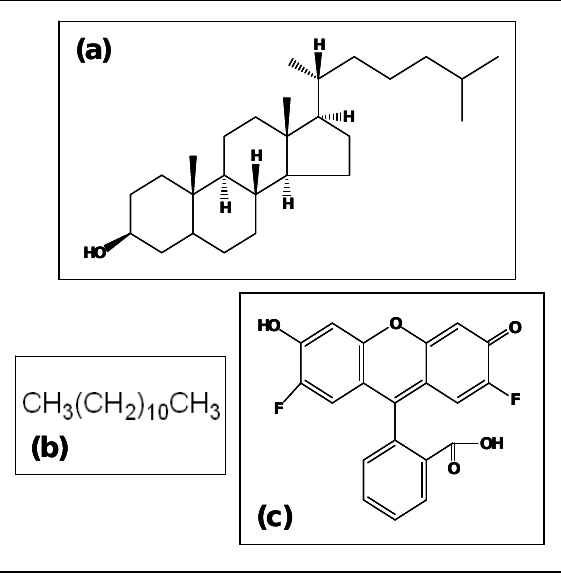
Figure 6. Structures of compounds. (a) Cholesterol (b) Dodecane (c) Oregon Green 488